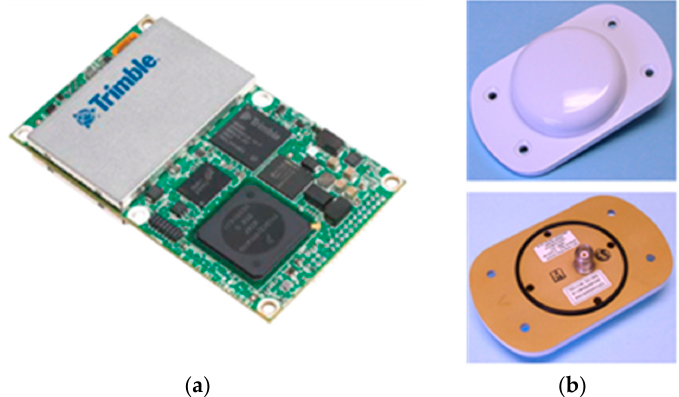
Figure 3. ( a ) Trimble BD970 Global Navigation Satellite System (GNSS) Original Equipment Manufacturer (OEM) board and ( b ) ANTCOM Global Positioning System (GPS) G5 antenna. (Source: Trimble Inc.)